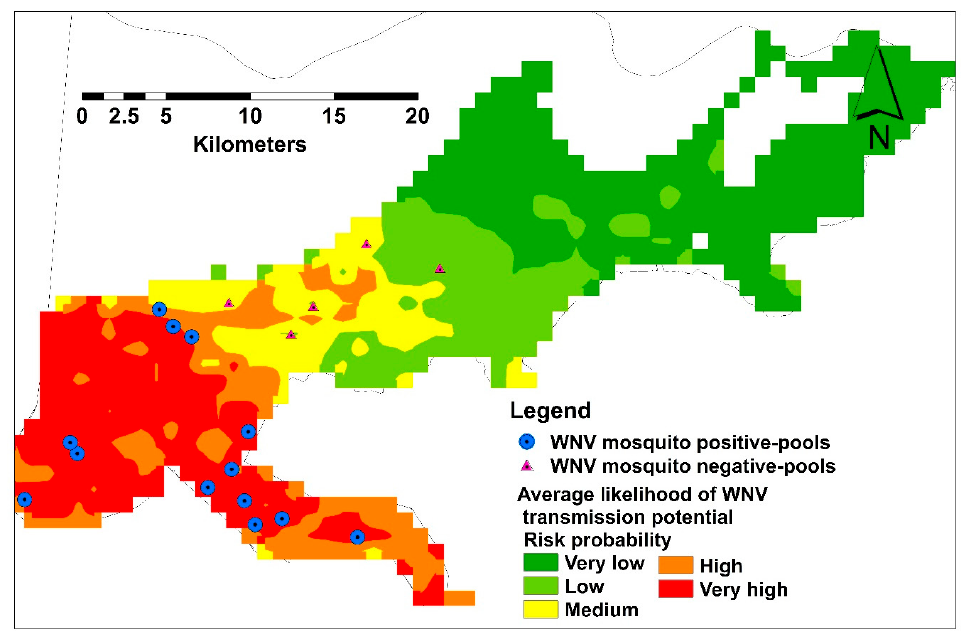
Figure 6. Average habitat suitability of infective mosquito showing field validation points.